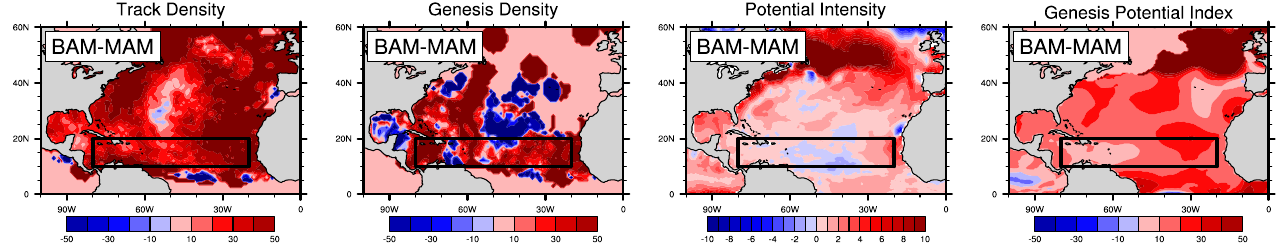
Figure 2. North Atlantic distribution for the difference (%) between the two models (BAM minus MAM) for ( first ) seasonal average track density, ( second ) seasonal average storm genesis density, ( third ) seasonal maximum potential intensity, and ( fourth ) seasonal average genesis potential index. Calculations are conducted for seasonal (June to November) average from 1982 to 2005. The MDR is shown as the black outline.